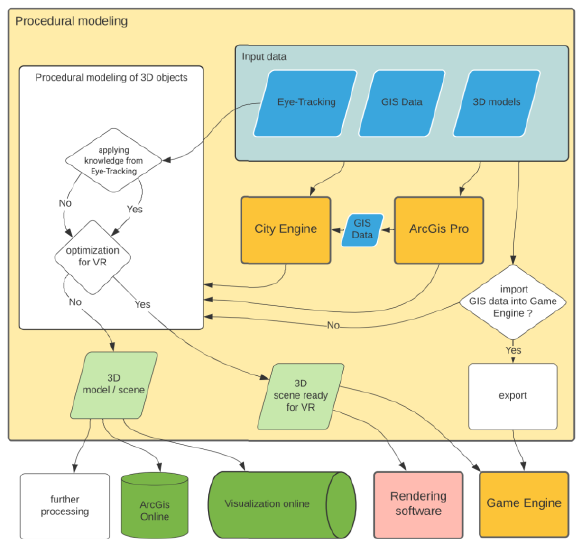
Figure 2 . Example of a diagram for procedural